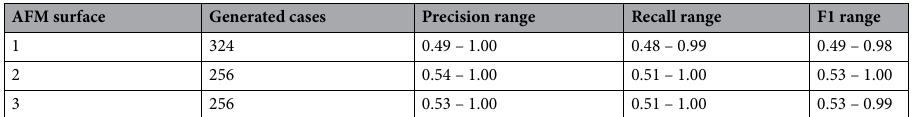
Table 2. Summary of generated defect sets for each AFM test image. Precision, recall and F1 values were computed against true defect sets annotated in the given AFM image.